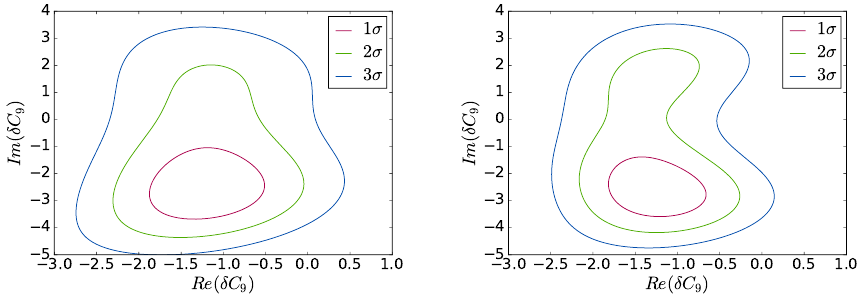
Figure 3 . Contour plots for real and imaginary parts of (cid:14)C 9 when both (cid:14)C 9 and (cid:14)C 7 are allowed to di(cid:11)er from zero. For each plane, the (cid:31) 2 is minimised over the remaining two parameters. The contours on the left correspond to (cid:12)ts up to q 2 = 6 GeV 2 , and the contours on the right correspond to (cid:12)ts up to q 2 = 8 GeV 2